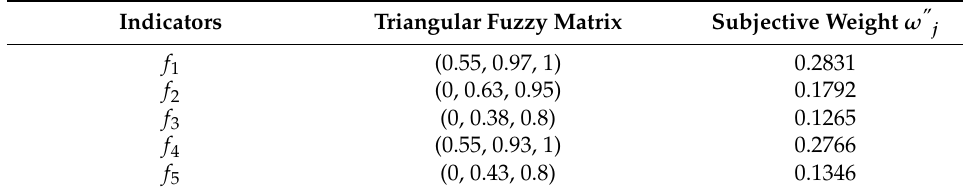
Table 9. Triangular fuzzy matrix and subjective weight of each index.